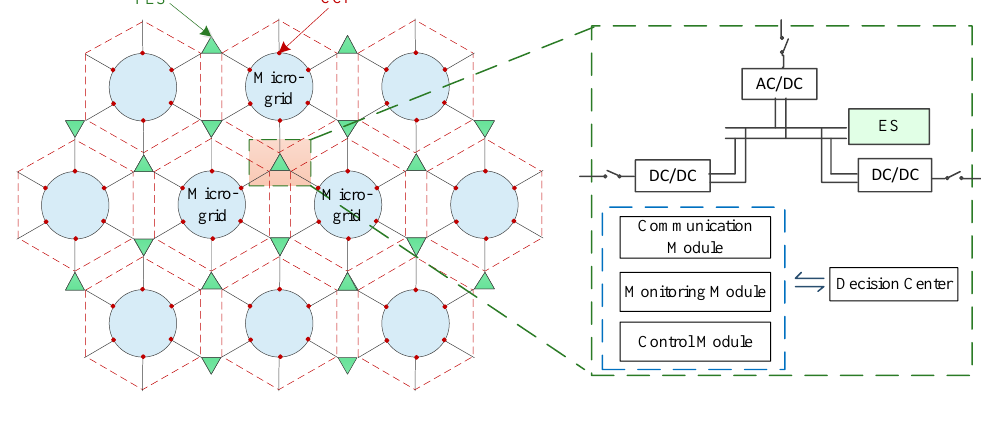
Figure 1. Structure of